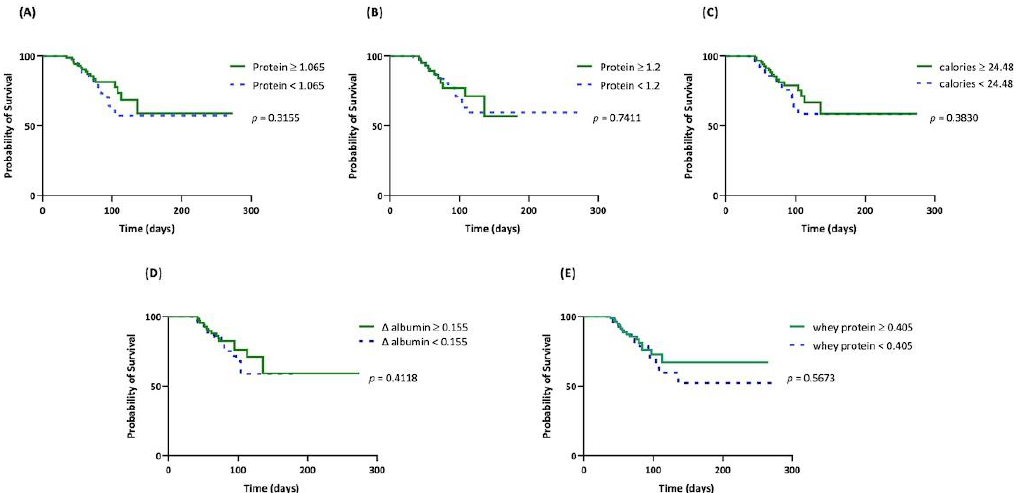
Figure 4. Kaplan–Meier survival curve of survival outcomes for different nutritional parameters. Figure 4. Kaplan – Meier survival curve of survival outcomes for different nutritional parameters.